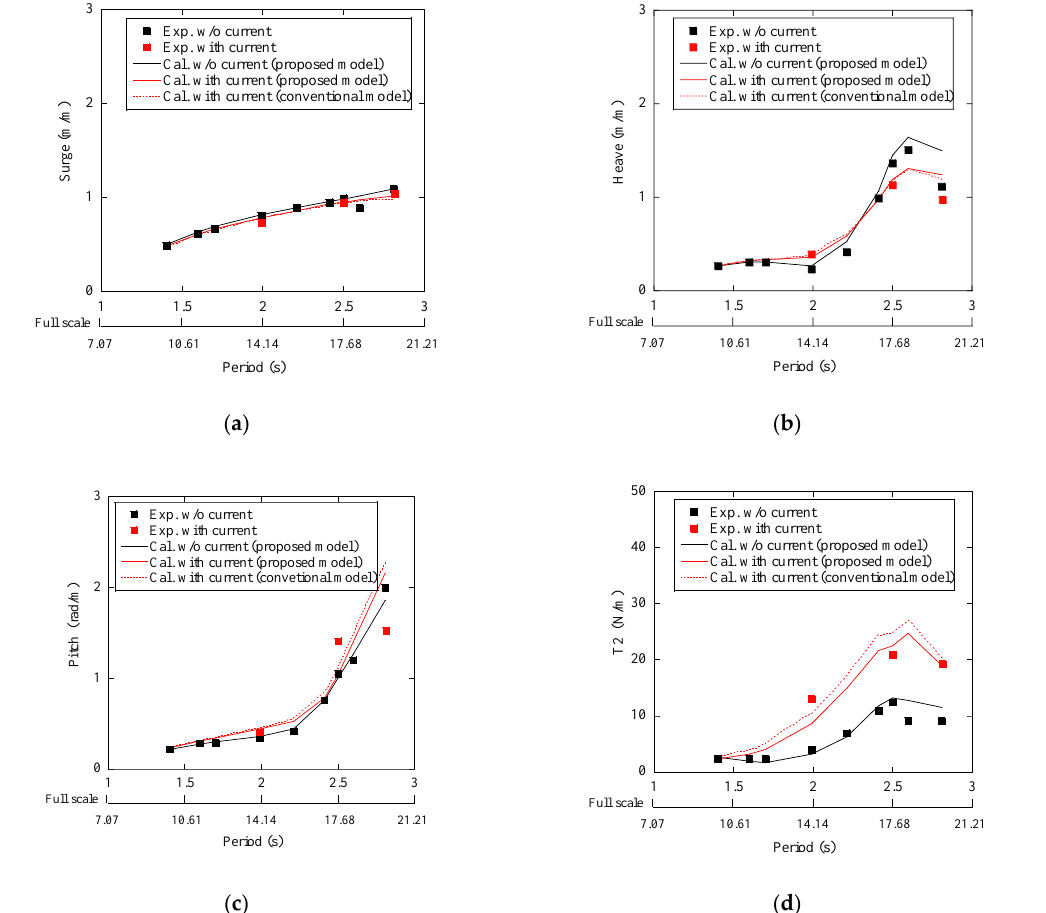
Figure 12. Comparison of predicted and measured response amplitude operators (RAOs) of the platform in the wave-only and combined wave-current conditions. ( a ) RAO of surge motion, ( b ) RAO of heave motion, ( c ) RAO of pitch motion and ( d ) RAO of mooing tension for ML2.